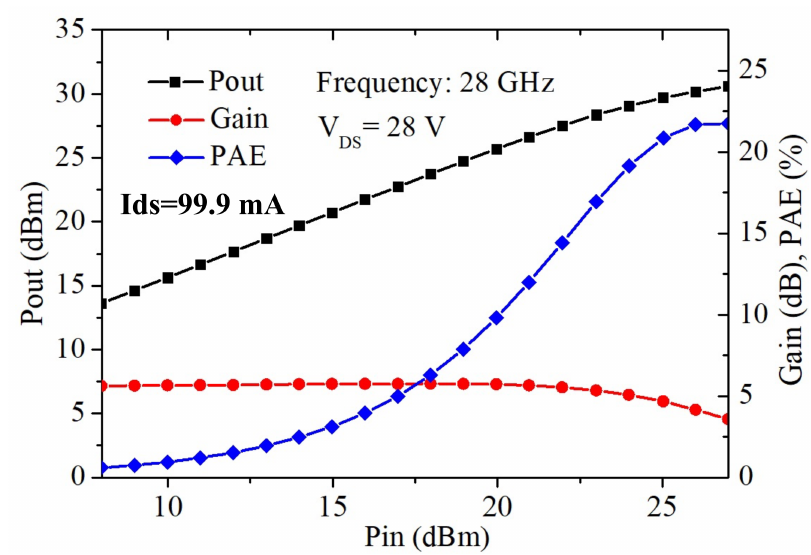
Figure 6. Power performance at 28 GHz for the 8 × 50 µ m GaN:C/EBL buffer device with V DS = 28